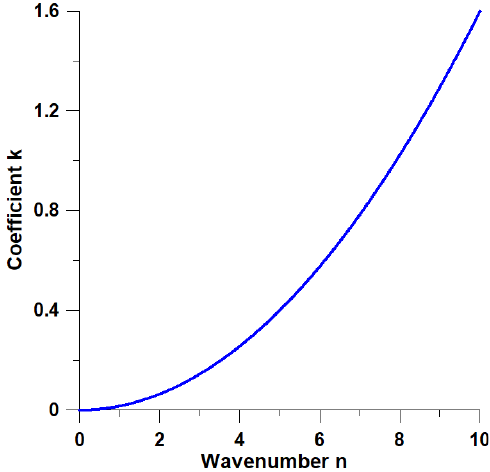
Figure 7: The change of the dimensionless flutter characteristics for simply supported square plates.